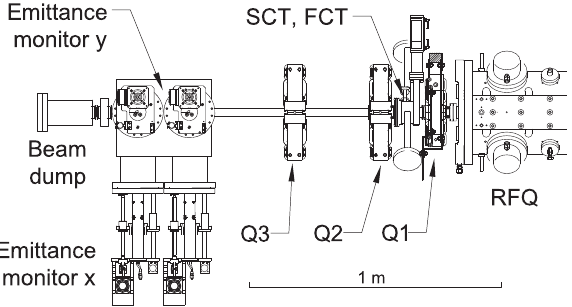
FIG. 8. Schematic side view of the test